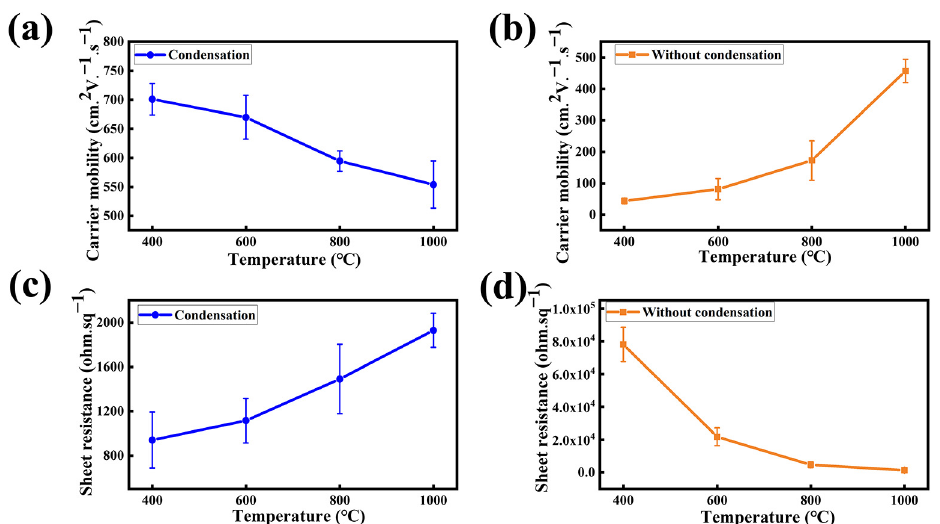
Figure 5. Graph of the carrier mobility of NG films at different synthesis temperatures of 400 ◦ C, 600 ◦ C, 800 ◦ C, and 1000 ◦ C, ( a ) with using condensation treatment and ( b ) without using condensation treatment. Graph of the sheet resistance of NG films at different synthesis temperatures of 400 ◦ C, 600 ◦ C, 800 ◦ C, and 1000 ◦ C, ( c ) with using condensation treatment and ( d ) without using condensation treatment.